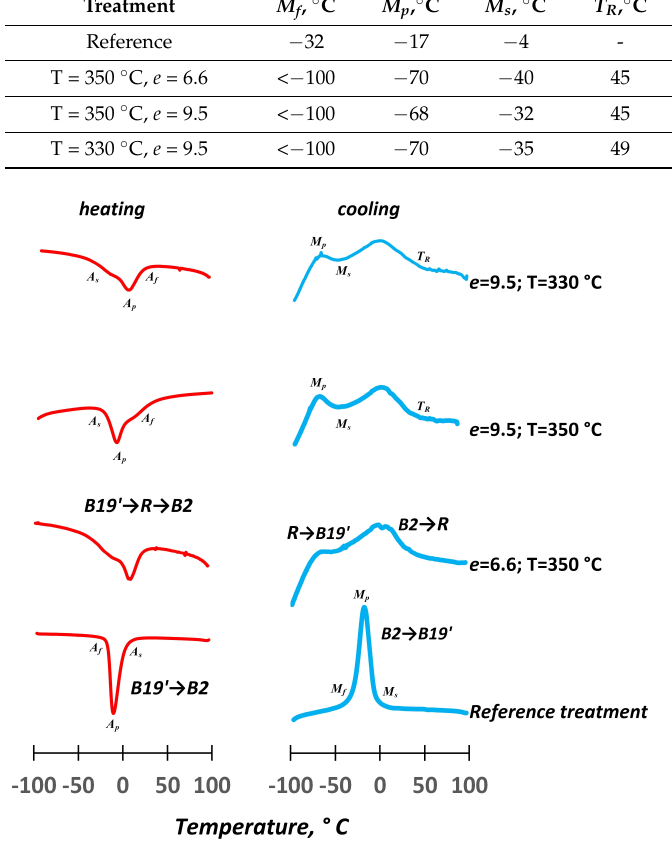
Table 1. Characteristic temperatures of martensitic transformation of NiTi SMA. Table 1: Ms , M f and A s , A f are start and finish temperatures of the forward and reverse